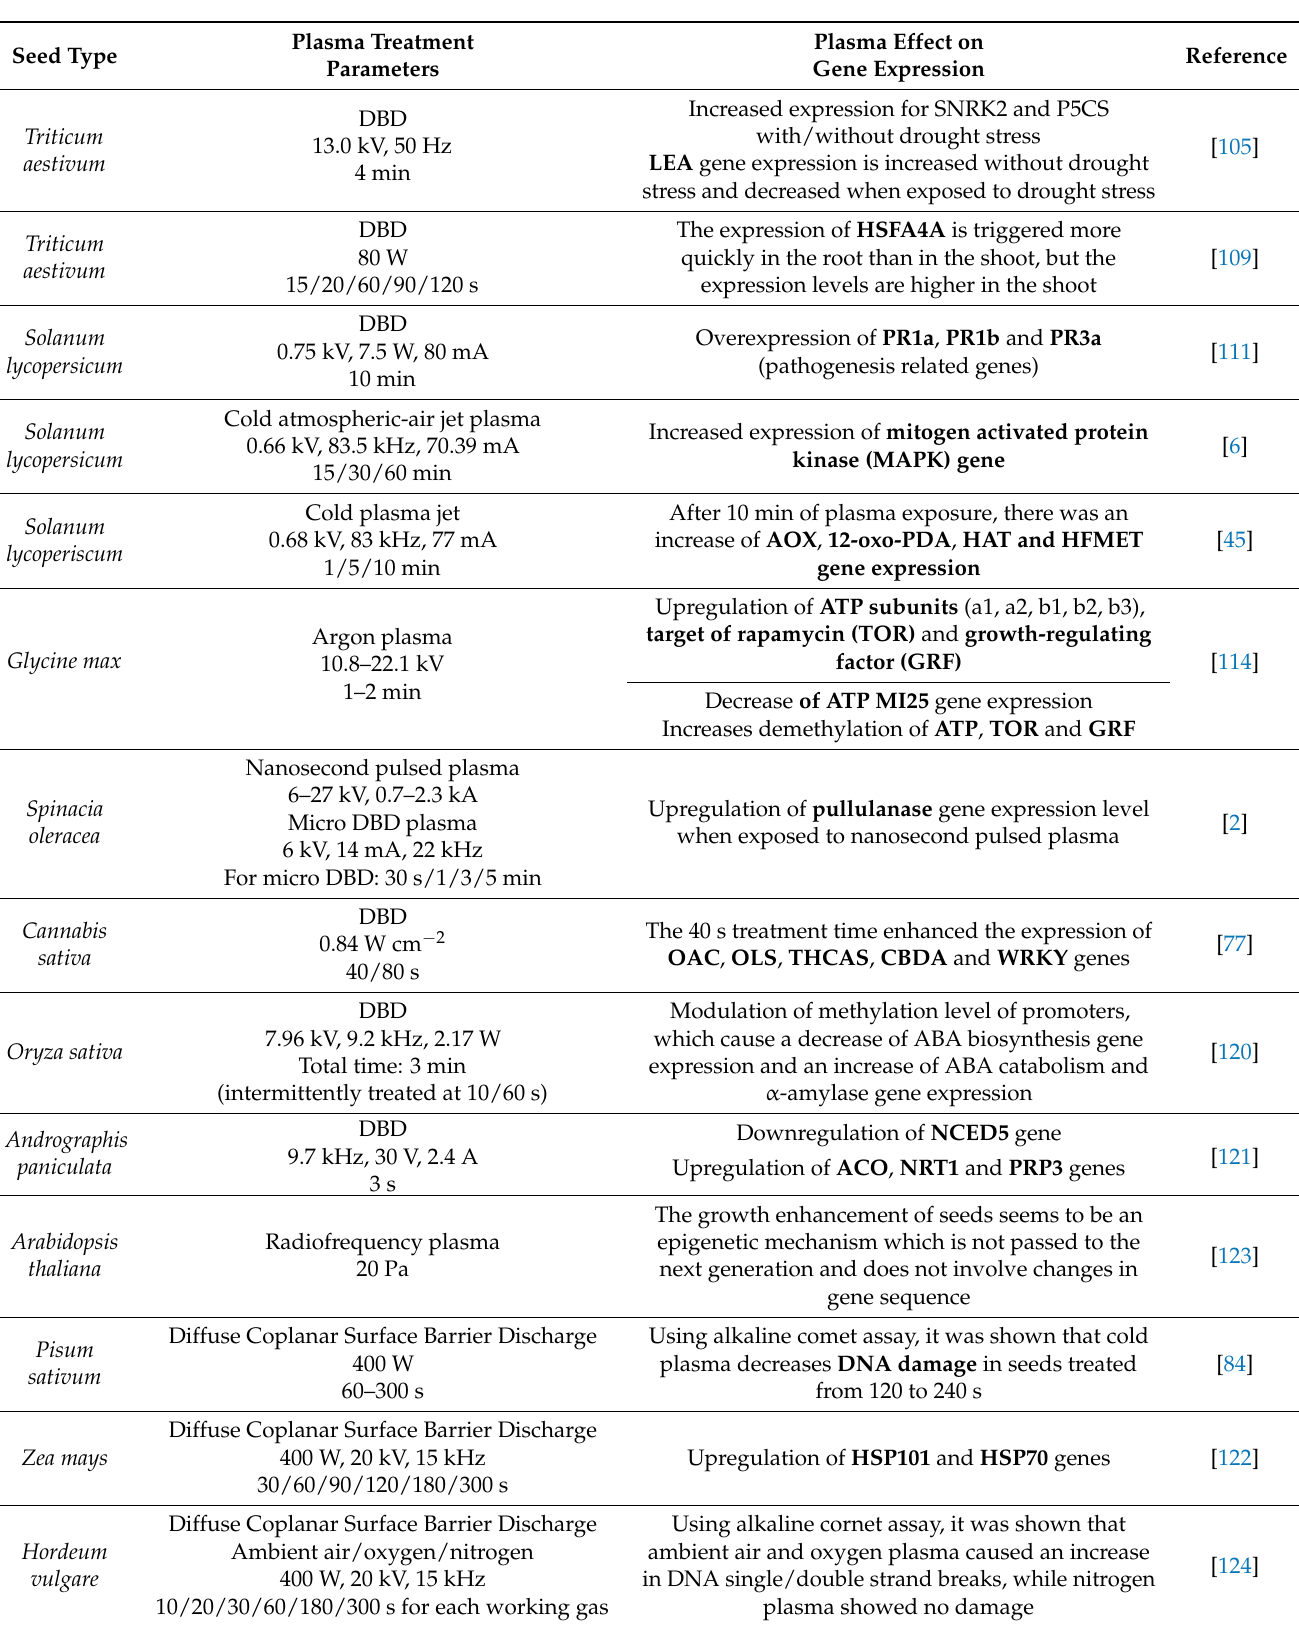
Table 1. An overview of the non-thermal plasma effects on gene expression of various species of